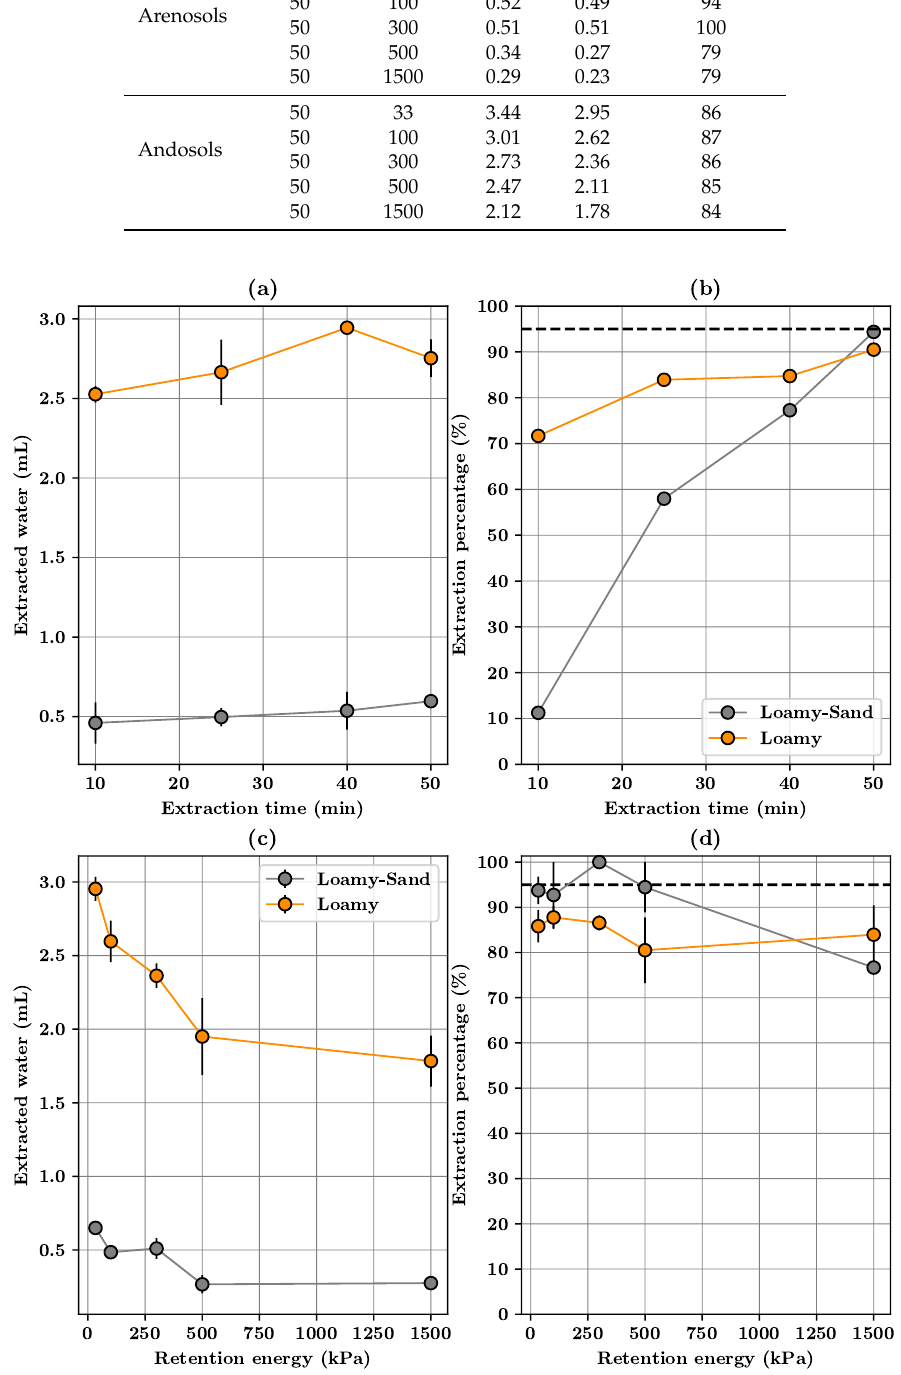
Figure 3. Experiment A: ( a ) Variation of extracted volumes of water after different extraction times ( b ) Variation of extraction percentages after different extraction times. For Experiment B ( c ) Variation of extracted volumes of water for different starting water contents ( d ) Variation of extraction percentages for different starting water